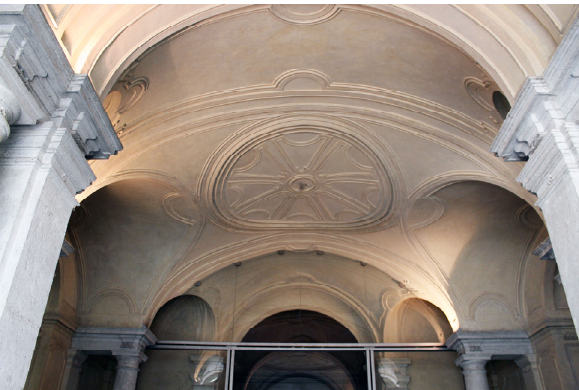
Figure 1 . Atrium of Palazzo Mazzonis in Turin, seat of the Museo d’Arte Orientale (MAO). Photo: F.